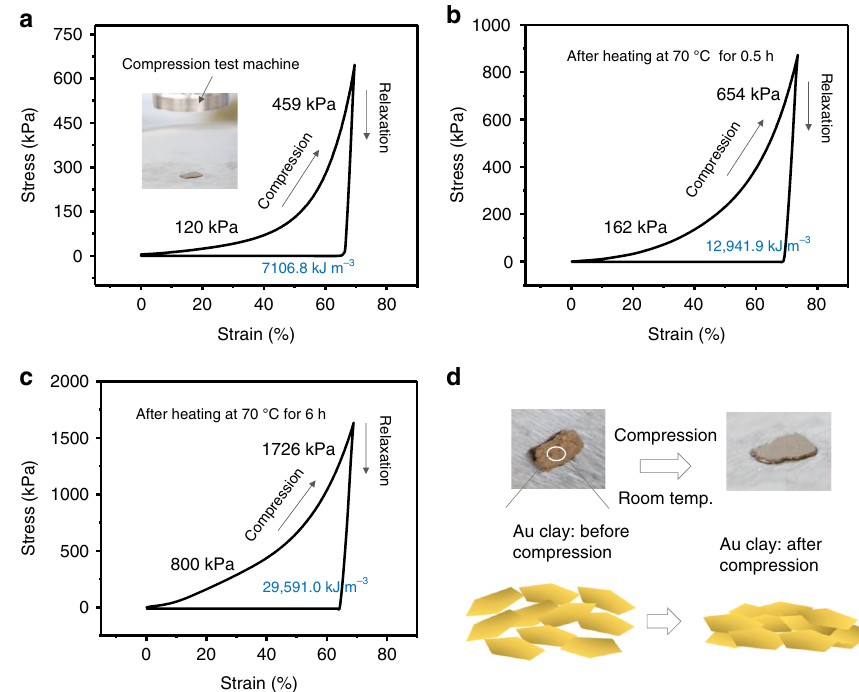
Fig. 4 Plastic property of the soft gold metals from nanosheet assemblies. a – c Compressive stress − strain curves of gold nanosheet assemblies at room temperature ( a ) without annealing, and after annealing at a mild temperature of 70 °C for b 0.5 h and c 6 h. The hysteresis between compression and relaxation curves indicates plastic deformation. The calculated stiffness values at a strain of 10 and 60% are shown in the graphs. When thermal annealing is applied, energy dissipation (area between the loading and unloading curves) increases from 0.71 × 10 4 to 2.96 × 10 4 kJ m − 3 . d Images and schematic illustration of nanosheet assemblies under compressive stress.